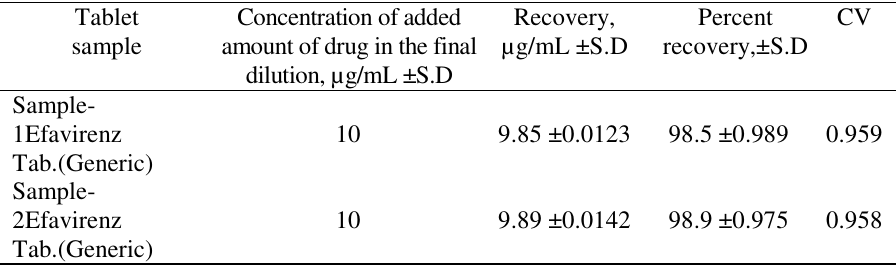
Table 5 . Efavirenz estimation in dosage form in recovery studies by proposed